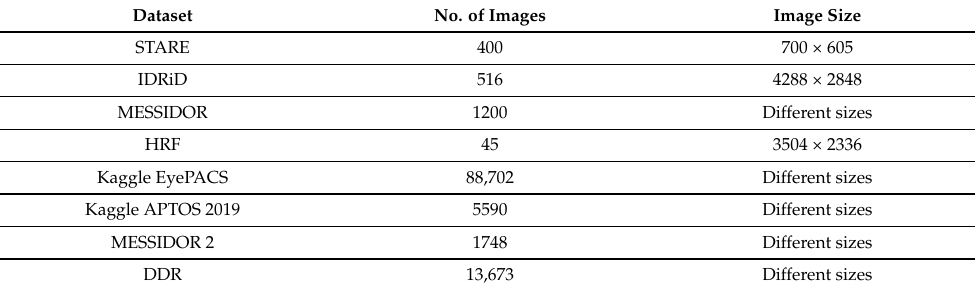
Table 2. Diabetic retinopathy datasets.